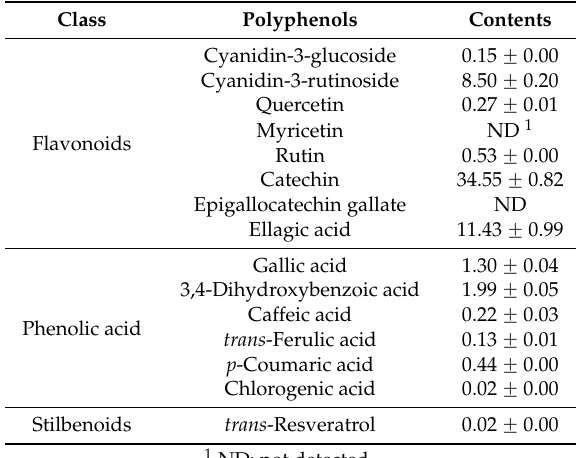
Table 1. Contents of polyphenols in RCSF1 by LC/MS/MS (mg/g).